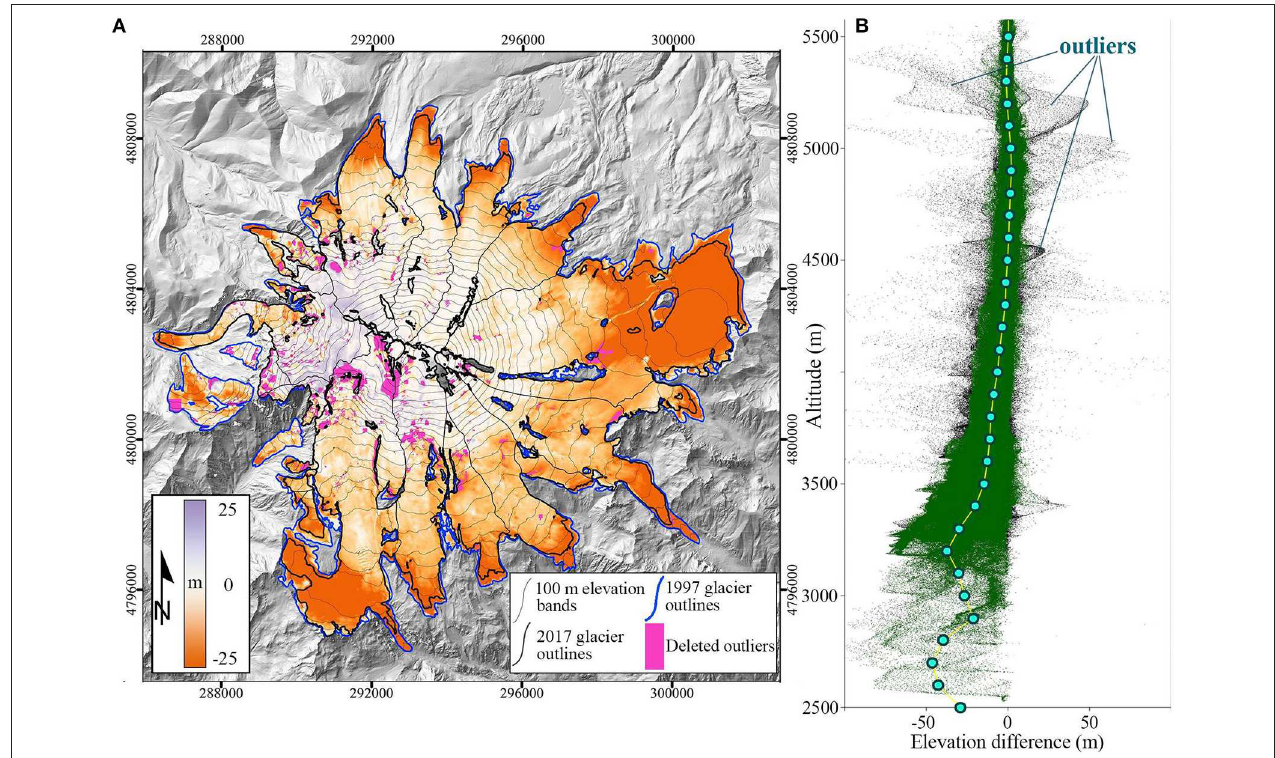
FIGURE 4 | (A) Surface elevation changes of Mt. Elbrus glaciers in 1997-2017. Thin black lines mark the 100m elevation contours, and thick lines separate glacier basins. (B) Plot shows the 1 h distribution vs. altitude. Green color marks points used in the calculations, black points show deleted outliers (corresponding to pink shaded areas on the map). Blue points indicate mean 1 h values for every 100m elevation band. Pléiades DEM of 2017 used as a